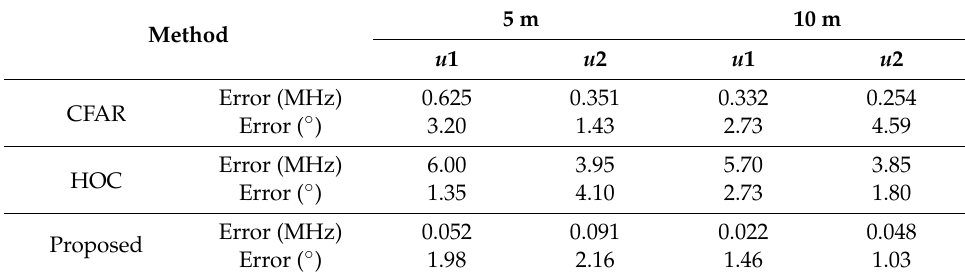
Figure 27. The CFAR method results for two UAVs indoors at distances of ( a ) 5 m and ( b ) 10 m. Table 5. Parameter estimation errors for two UAVs using three methods in an indoor environment.